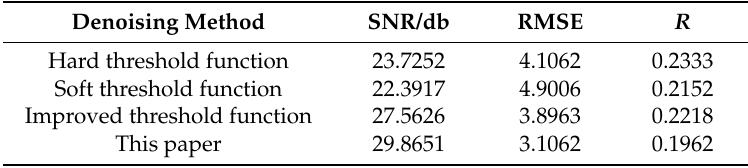
Table 1. The comparison of de-noising results for different threshold